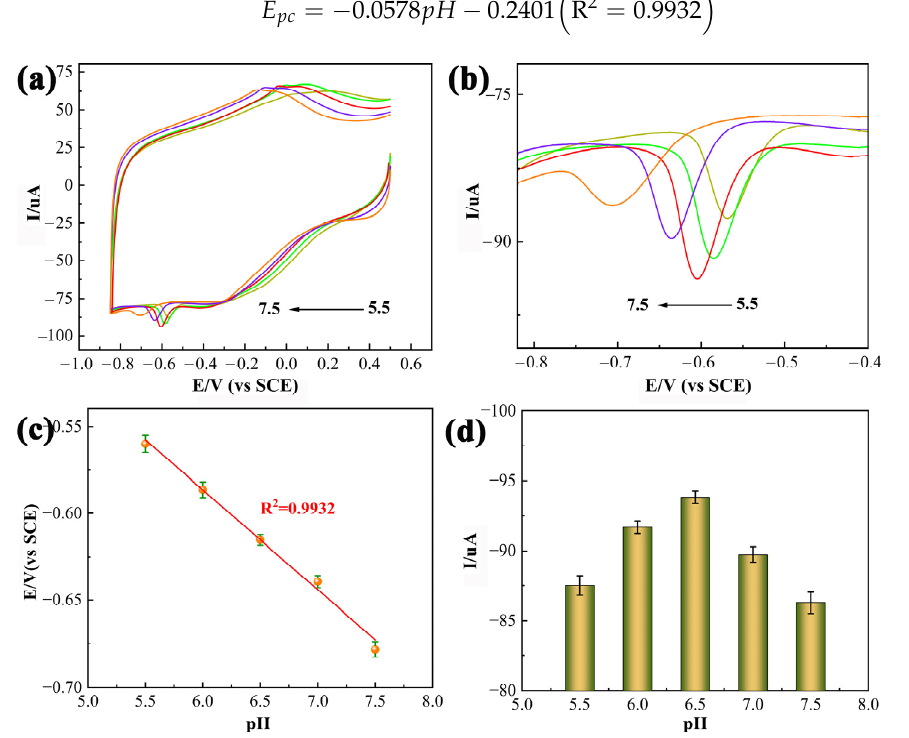
Figure 7. ( a ) CV curves of 0.01 mM CAP at the PDPP/GO/GCE at various pH values from 5.5 to 7.5 and an enlarged view ( b ), scan rate: 50 mV/s; ( c ) linear relationship of E Pc versus the pH value; ( d ) the plot of I pc versus the pH value.